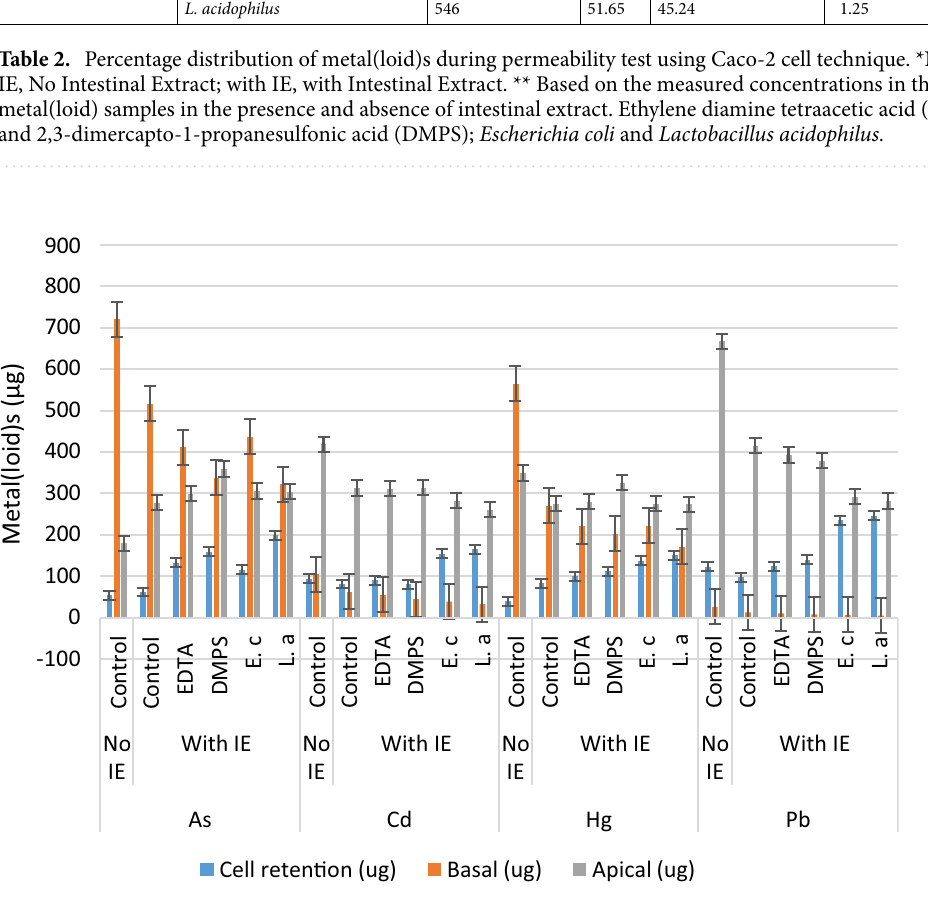
Figure 2. Distribution of metal(loid)s in the apical chamber, basolateral chamber and retention by cells during permeability test using Caco-2 cell technique. IE, intestinal extract; EDTA, ethylenediaminetetraacetic acid; DMPS, 2,3-dimercaptopropane-1-sulfonate; ; E.c , Escherichia coli ; L.a , Lactobacillus